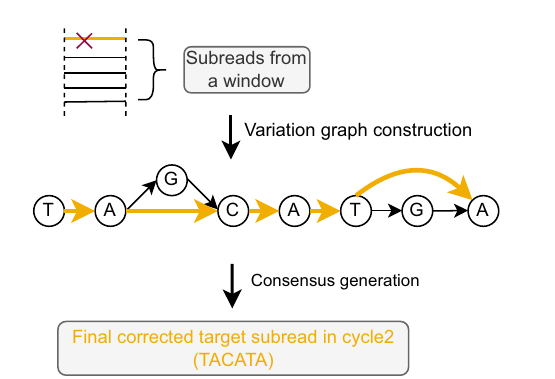
Fig. 3 | Error correction for one target subread in cycle 2. The bold orange path indicates the consensus sequence. The false nucleotide 'G' in the pre-corrected target subread in cycle 1 (see in Fig. 2) is marked with red and further corrected in cycle 2.